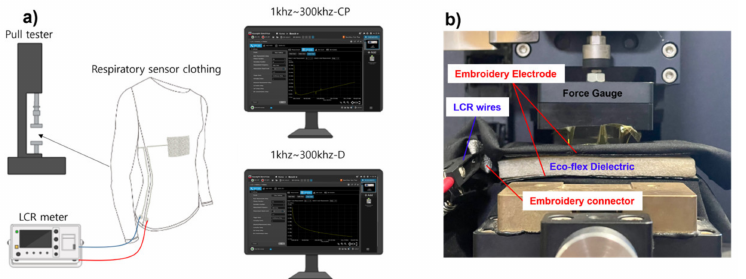
Figure 14. ( a ) Schematic of the universal testing machine. ( b ) Measurement setup for the proposed capacitance respiratory sensor with porous Eco-flex dielectric.